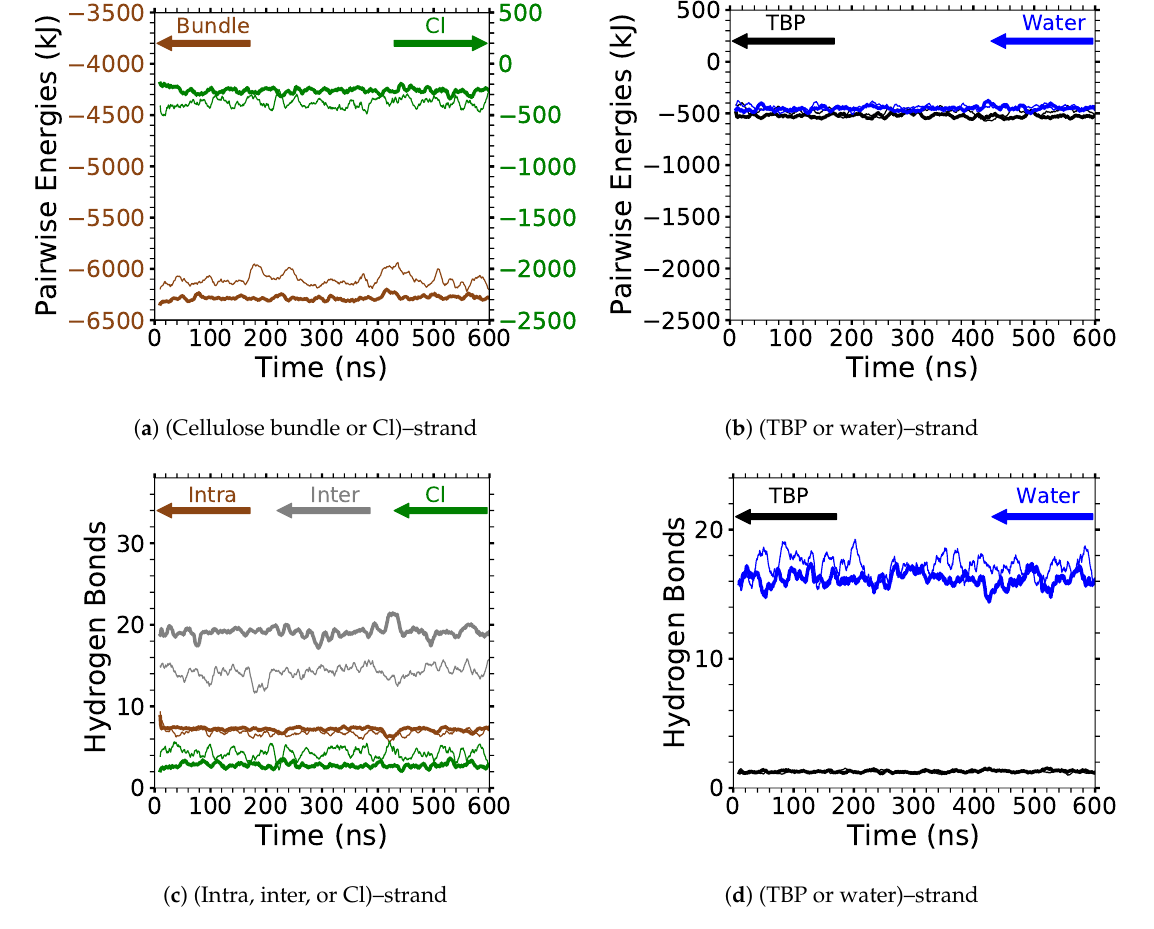
Figure A19. Pairwise energies and hydrogen bonding of the peeling strand(s) at 95.8mol%water and 360K. The pairwise energies of the separating strand(s) between the: ( a ) (cellulose bundle or Cl)–separating strand; ( b ) (TBP or water)–separating strand. The number of hydrogen bonds for the separating strand(s) per the given type: ( c ) (intra, inter, or Cl)–separating strand; ( d ) (TBP or water)–separating strand. The thick line is the first yellow strand to peel, and the thin line is the non-peeling yellow strand or second strand to peel. If neither of the stands peel, then both the thick and thin lines are non-peeling yellow strands. The data were averaged over 1000 data points, using a rolling